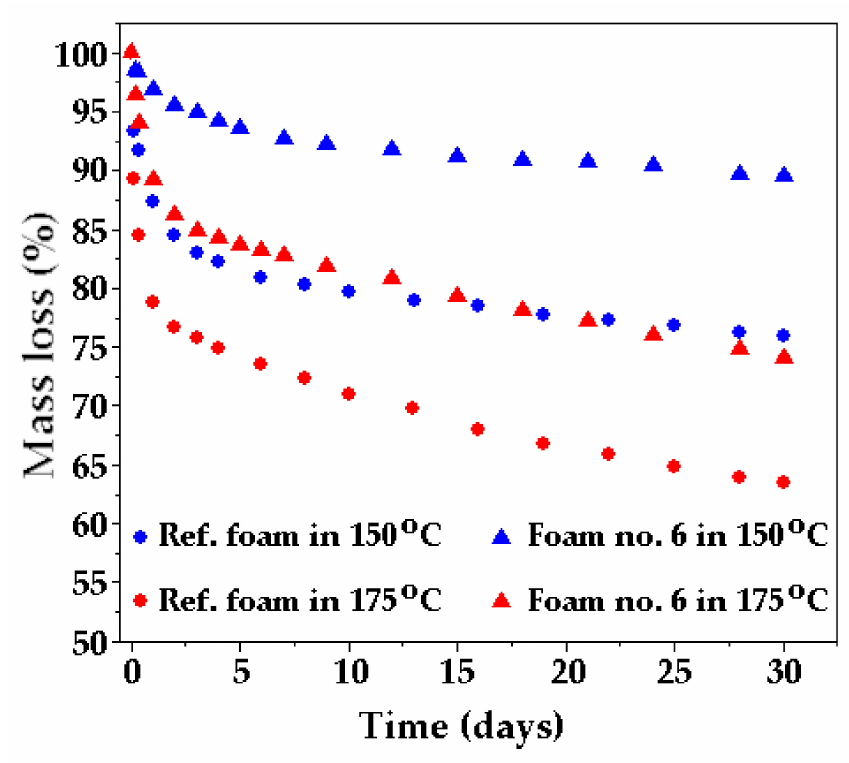
Figure 4. Comparison of mass loss of foams during 30-day exposure at elevated